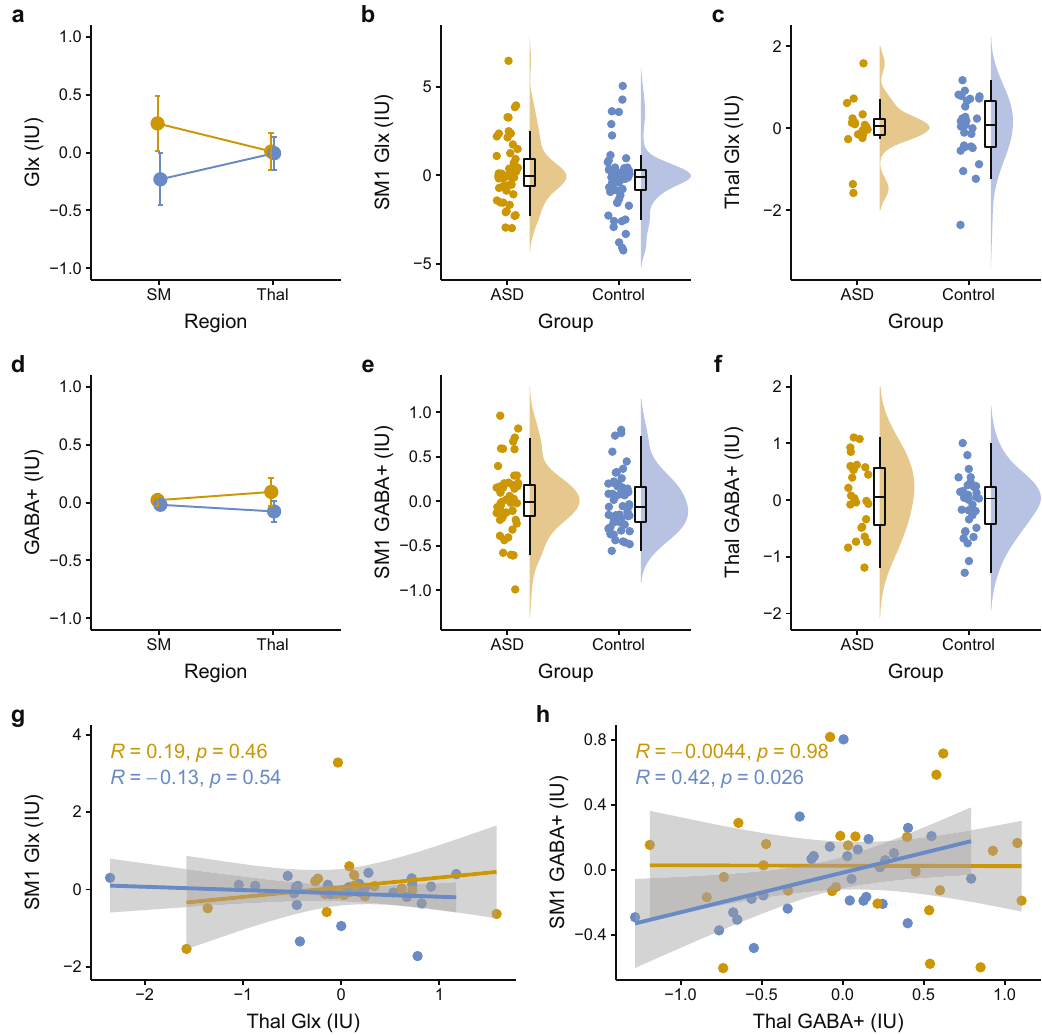
Fig. 3 Region-speci fi c increase in Glx but not GABA + in ASD. The ASD and TDC group are depicted as yellow and blue (respectively). a Evidence towards a Group by Region interaction effect on Glx (IU). b Higher Glx (IU) levels in the SM1 voxel for children in the ASD compared to TDC group. c Low evidence towards a meaningful group difference in Glx (IU) levels in the Thal voxel . d Lack of evidence towards a signi fi cant Group by Region interaction effect on GABA + (IU) levels. e Comparable GABA + (IU) in SM and f Thal voxels between children in the ASD and TDC groups. g Linear relationship between SM Glx and Thal Glx in ASD that is otherwise absent in TDC. h No relationship between SM GABA + and Thal GABA + in either ASD or TDC. IU institutional units, Glx glutamate + glutamine, Cr creatine, SM1 primary sensorimotor cortex, Thal thalamus, ASD autism spectrum disorders, TDC typically developing controls. Note: p -values presented on panels g and h are not corrected for multiple comparisons, please refer to the p -values in the main text. Error bars in panels a and d represent standard error. The shaded area around the line of best fi t represents the 95% con fi dence Thal GABA + is associated with sensory seeking behaviors . There concentration for each region. We identi fi ed an association were no signi fi cant associations between SM1 GABA + and any of between Thal GABA (when referenced to both water and creatine) the total scores on the SEQ (all p Bonferroni > 0.060 ) . There was also and ADOS communication scores ( r = 0.44, p Bonferroni = 0.081, no signi fi cant moderating effect of Group (all p Bonferroni > 0.969). GABA + /Cr: r = 0.54, p Bonferroni = 0.022), which we highlight in There was a trend towards an association between Thal GABA + the Supplementary Fig. 5. and parent reported sensory seeking total scores ( r = 0.34, p Bonferroni = 0.054; Fig. 4c). There was otherwise no meaningful Correlations between metabolite levels of SM1 and Thal with association between Thal GABA + with either hyper- ( r = 0.21, tactile sensitivity SM1 and Thal Glx with tactile perception . When collapsing across groups, there was evidence for linear associations between SM1 Glx levels and sequential frequency discrimination thresholds ( r = − 0.22, p Bonferroni = 0.158; Fig. 4d) and the effect of simultane- ity (i.e., the difference between simultaneous and sequential also explored whether there were any associations between frequency discrimination thresholds; r = 0.27, p Bonferroni = 0.052), autism severity and individual differences in metabolite though these associations did not survive correction for multiple